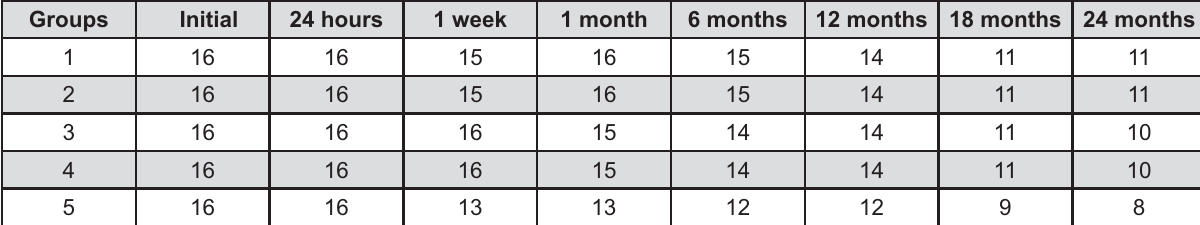
Figure 5- (cid:5)(cid:27)(cid:21)(cid:28)(cid:22)(cid:29)(cid:21)(cid:30)(cid:31)(cid:22)(cid:21)(cid:15)(cid:14)(cid:5)(cid:15)(cid:16)(cid:5)(cid:22)(cid:23)(cid:19)(cid:5)(cid:14)(cid:31)(cid:24)(cid:30)(cid:19)(cid:29)(cid:5)(cid:15)(cid:16)(cid:5)(cid:28)(cid:31)(cid:30)!(cid:19)(cid:18)(cid:22)(cid:28)(cid:5)(cid:22)(cid:23)(cid:25)(cid:22)(cid:5)(cid:29)(cid:19)(cid:22)(cid:31)(cid:29)(cid:14)(cid:19)"(cid:5)(cid:16)(cid:15)(cid:29)(cid:5)(cid:19)(cid:25)(cid:18)(cid:23)(cid:5)(cid:19)#(cid:25)(cid:26)(cid:31)(cid:25)(cid:22)(cid:21)(cid:15)(cid:14)(cid:5)$(cid:19)(cid:29)(cid:21)(cid:15)"(cid:5)(cid:16)(cid:15)(cid:29)(cid:5)(cid:25)(cid:26)(cid:26)(cid:5)%(cid:29)(cid:15)(cid:31)$(cid:28)(cid:5)(cid:19)#(cid:25)(cid:26)(cid:31)(cid:25)(cid:22)(cid:19)"(cid:5)(cid:2)(cid:14)&(cid:6)’(cid:9)